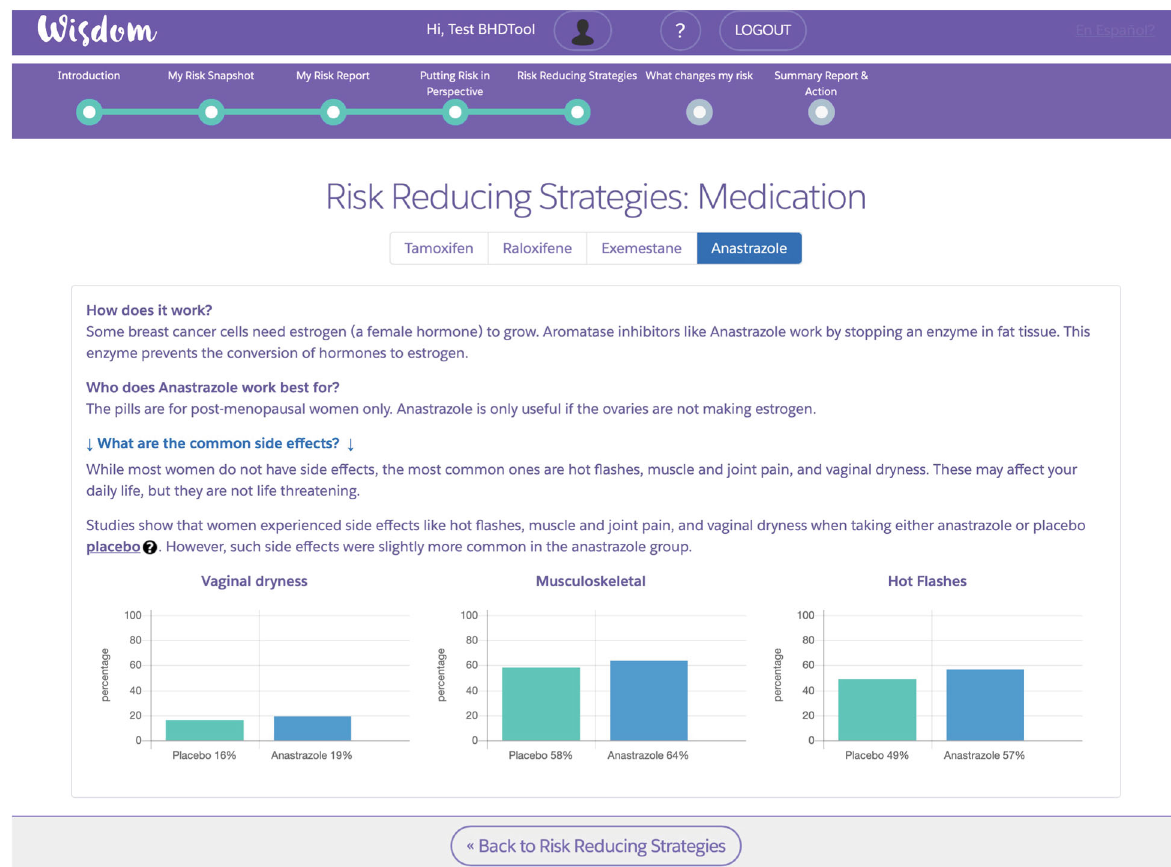
Table 1. The grade level was 8 and below for all pages. Reading ease varied from a low of 53.8% to a high of